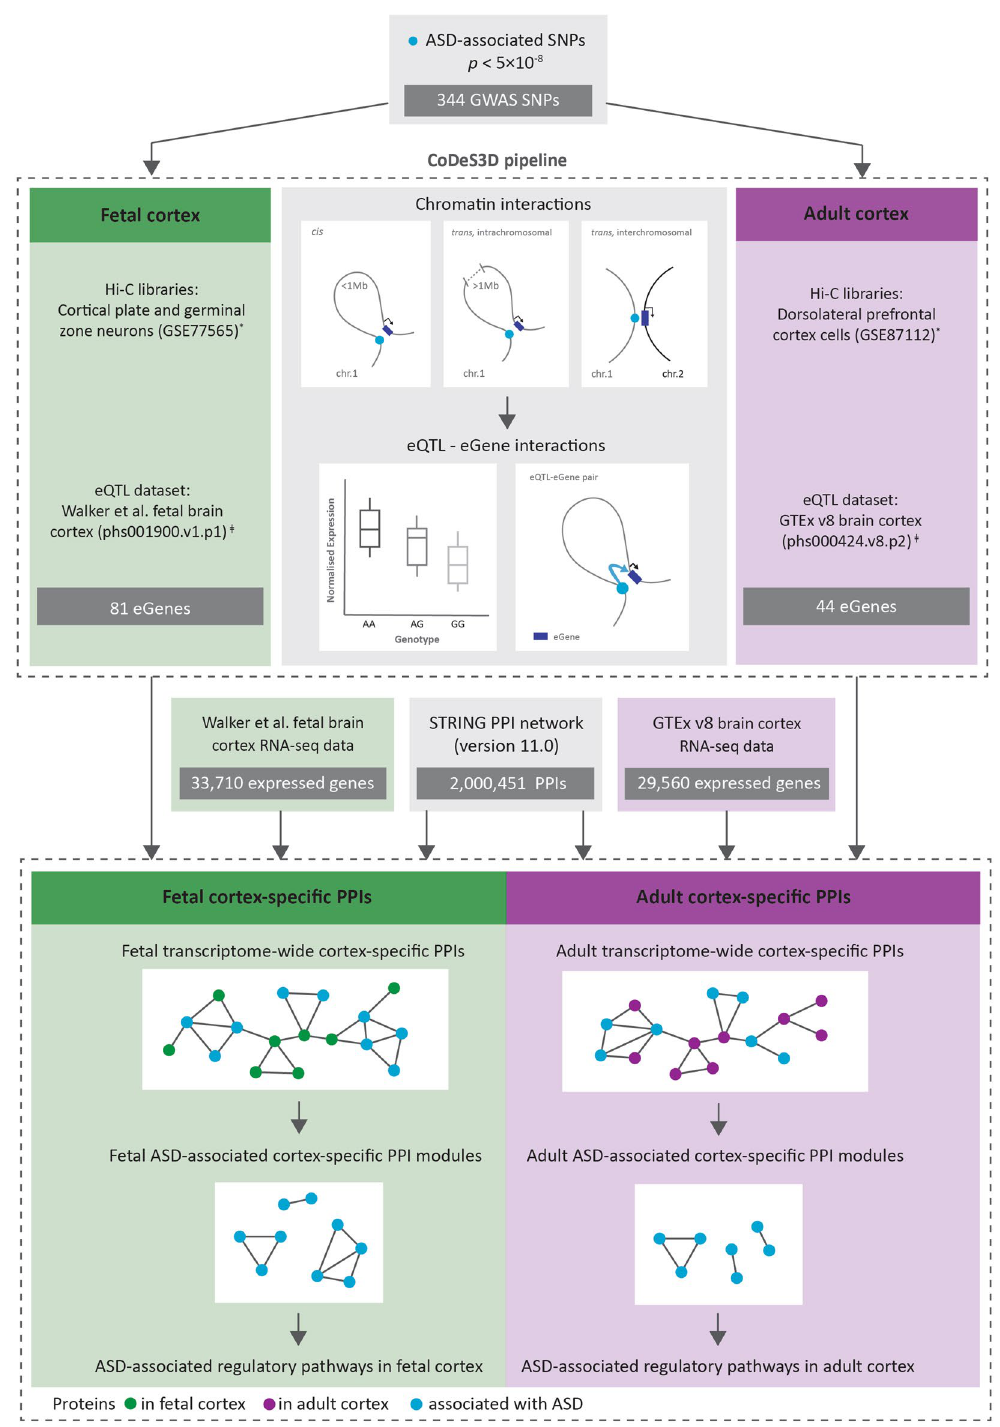
Figure 1. Overview of the analysis pipeline used in this study. 344 ASD-associated SNPs (p < 5 × 10 –8 ) represented in both fetal and adult cortex-specific eQTL datasets were run through the CoDeS3D pipeline to identify 81 and 44 spatially regulated genes in fetal and adult cortical tissues, correspondingly. Over 11 million protein–protein interactions (PPIs) were downloaded from STRING database (version 11.0) and combined with cortex-specific expression data (GTEx v8 or Walker et al. datasets) to construct tissue-specific transcriptome- wide PPI networks. Modules that were enriched with ASD-eQTL associated genes were identified in the fetal and adult cortical tissues. *Hi-C datasets for cortical plate and germinal zone neurons (phs001190.v1.p1) were obtained from Won et al. 19 , Hi-C datasets for adult dorsolateral prefrontal cortex cells were obtained from Schmitt et al. 12 . ǂ eQTL datasets for fetal and adult cortex were obtained from Walker et al. 20 and GTEx v8 21 ,